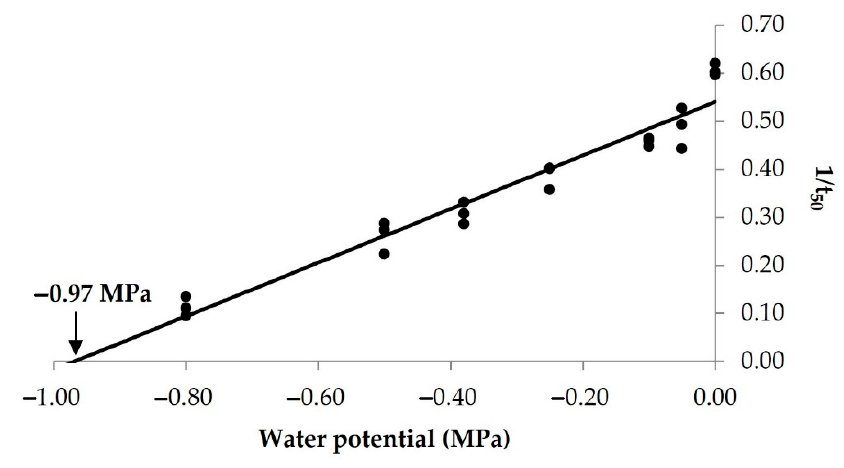
Figure 3. Estimated base water potentials ( Ψ b ) for the germination of Echinochloa crus-galli . The solid line represents the linear regression line, and the points represent the inverse value of the time necessary to reach 50% of germination (1/t 50 ) estimated for the single replicates. The estimated value of the base water potential is the intersection of the regression line with the X-axis, Ψ b = − 0.97 ± 0.06; y = 0.5578x + 0.5404, and R 2 = 0.94.